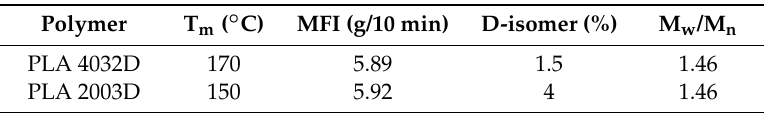
Table 1. Melt flow index (MFI), melting temperature (T m ), D-isomer content, and polydispersity index of the two polylactic acid (PLA)